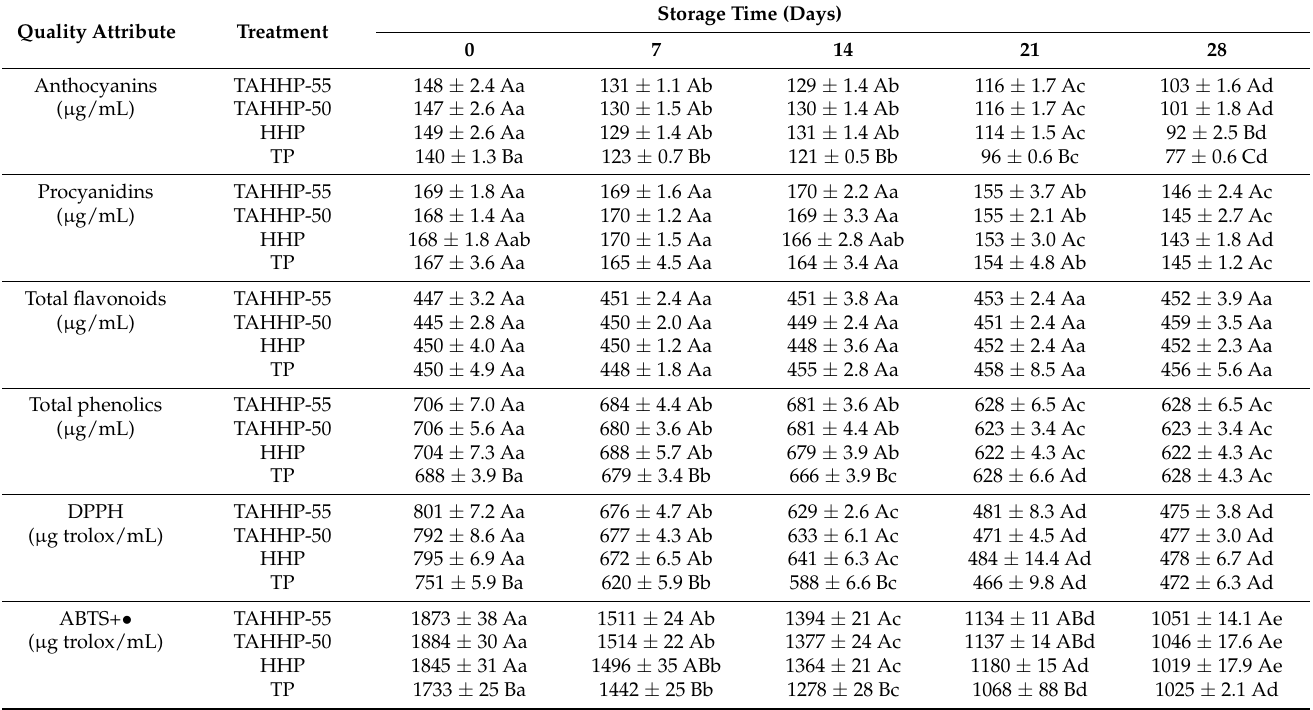
Table 3. Antioxidant properties of aronia juice during 28 days of storage at 4 ◦